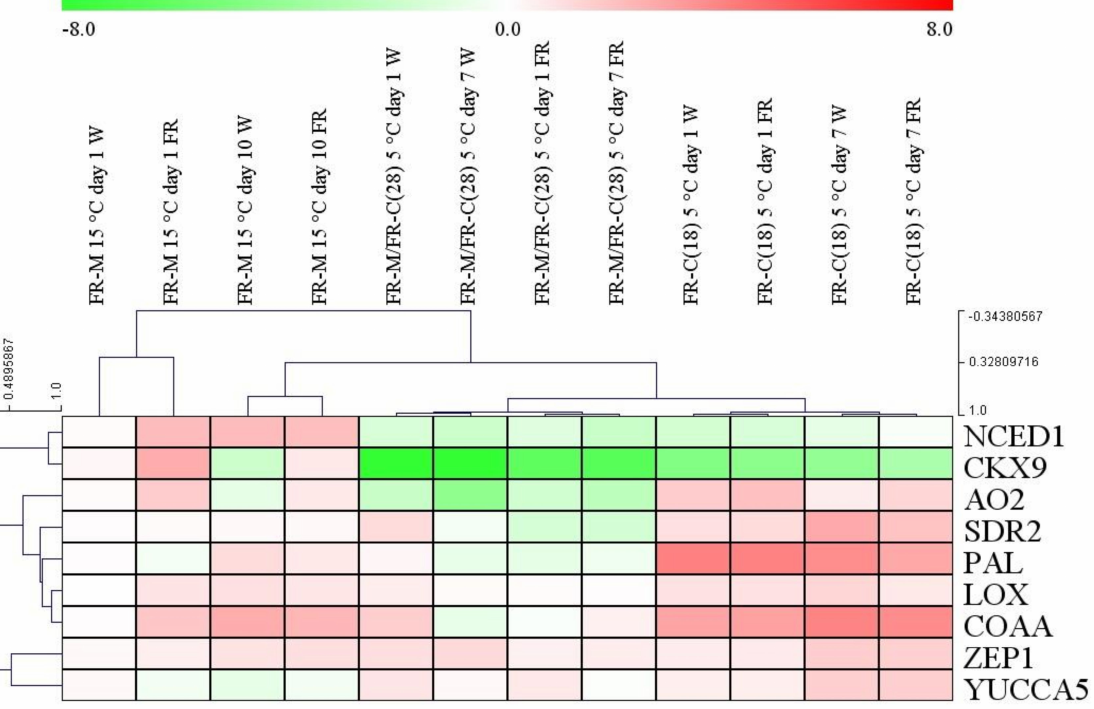
Figure 5. The effect of supplementary FR light and low temperature on the relative expression of the genes related to the hormone metabolism. Leaf samples were collected six to eight hours after the start of illumination. The plantlets were grown under 12 h photoperiod. Transcript levels were calculated with the ∆∆ Ct method. Log 2 expression values are shown. W: white light, FR: far-red-enriched white light. The data originated from three biological replicates. The values on the X and Y axis outside of the heatmap refer to the distance or proximity of data after hierarchical